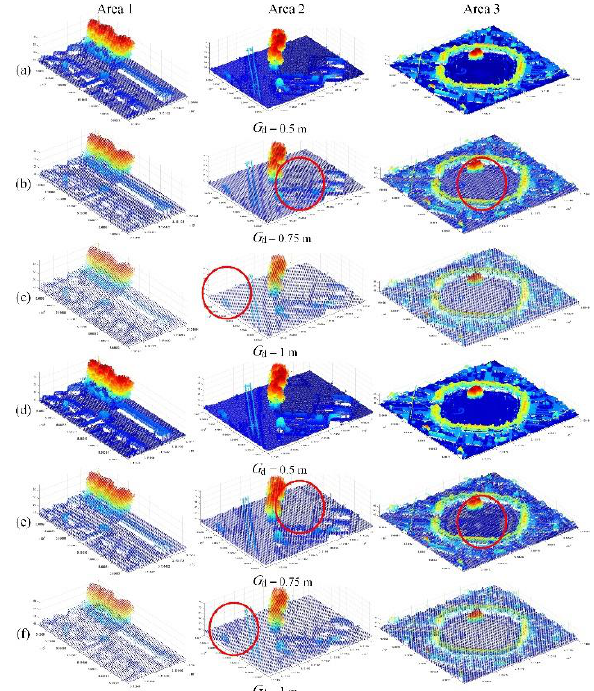
Figure 6 . The results of gridding the point clouds of the areas: 1, 2, and 3. a), b) and c) The results of the mesh method. d), e) and f) The results of the resampling method.